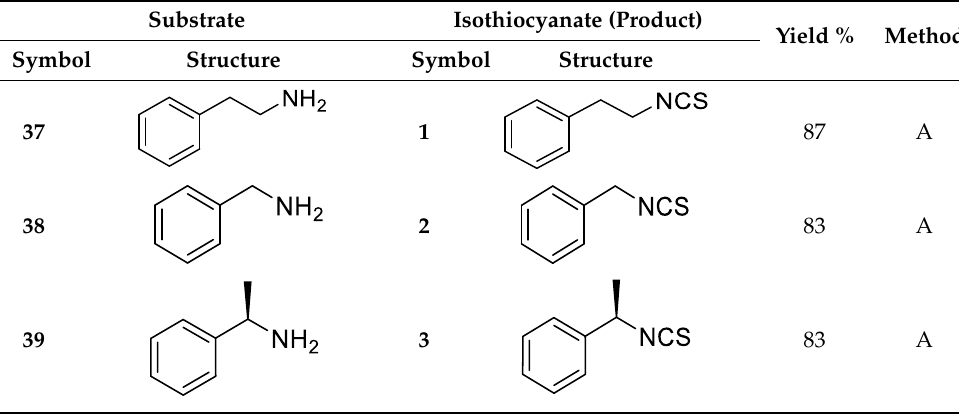
Table 1. Structure of tested isothiocyanates 1 – 36 a . Substrate